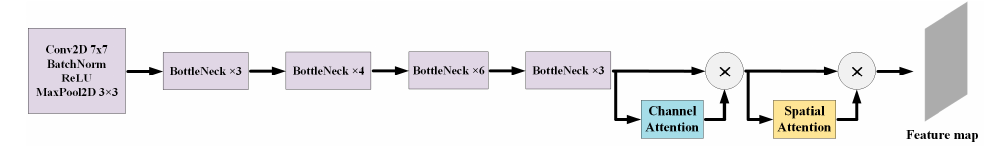
Figure 4. Improved feature extraction network.